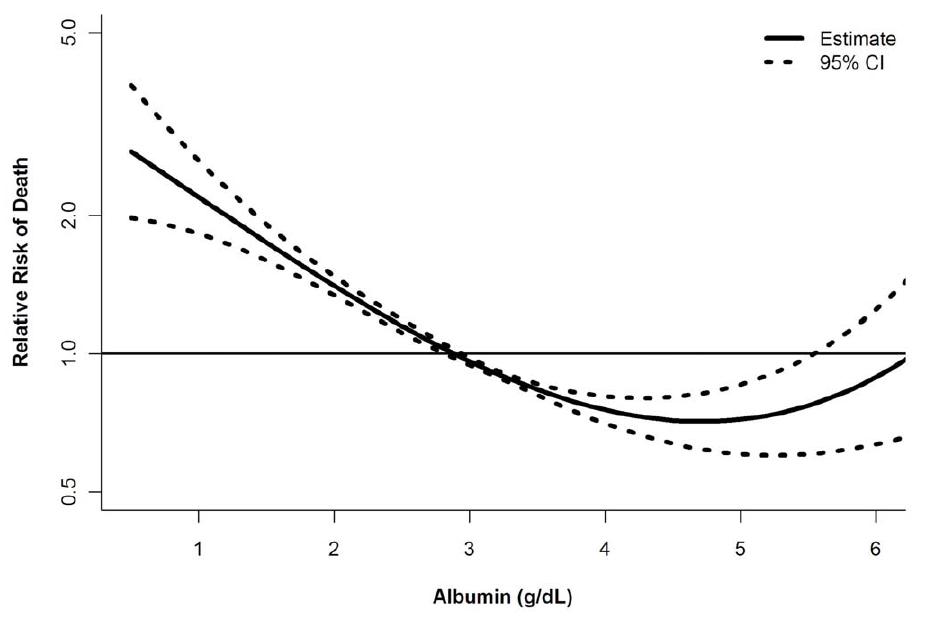
Figure 2. Serum albumin concentration and the risk of death within 3 months of waiting list registration after adjustment for the MELD score. Dotted lines represent 95% confidence intervals. lower serum sodium concentrations (Table 1). Hyperalbuminemic patients had worse hepatic and renal dysfunction, including greater MELD scores and a higher proportion requiring dialysis (16% vs. 4% in the other groups; P = 0.0001). Serum albumin was inversely correlated with MELD (Spearman’s rho= 2 0.41) and MELDNa (rho = 2 0.44), but positively correlated with serum sodium (rho = 0.30; all P , 0.0001).